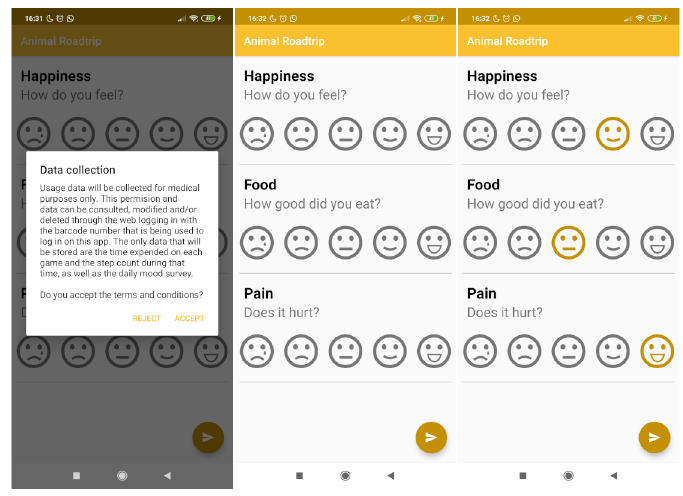
Figure 7. Overview of the daily survey